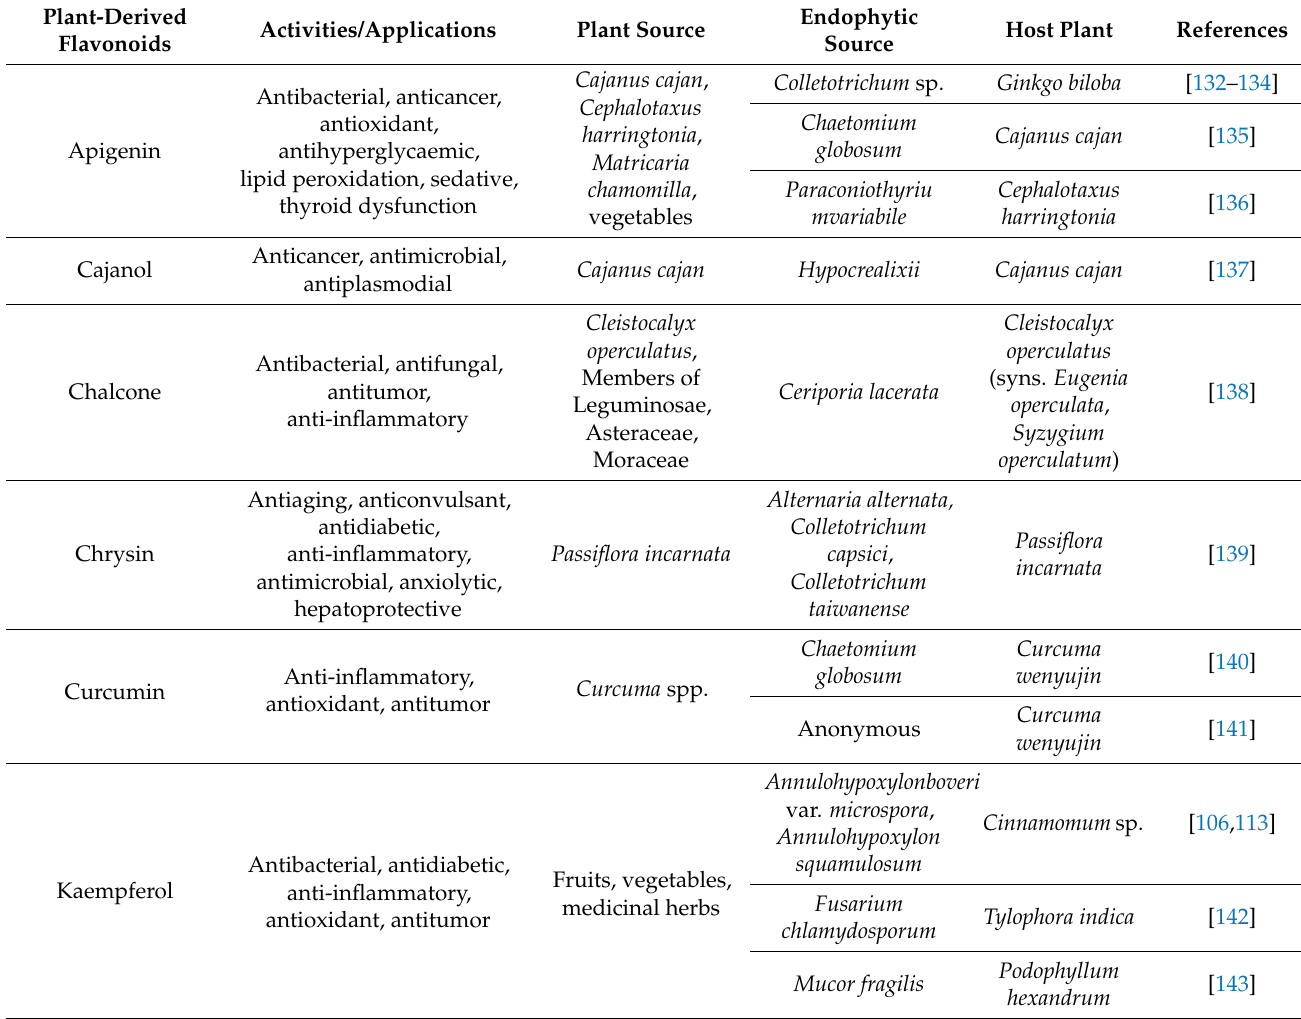
Table 3. Plant-derived flavonoids produced by endophytic